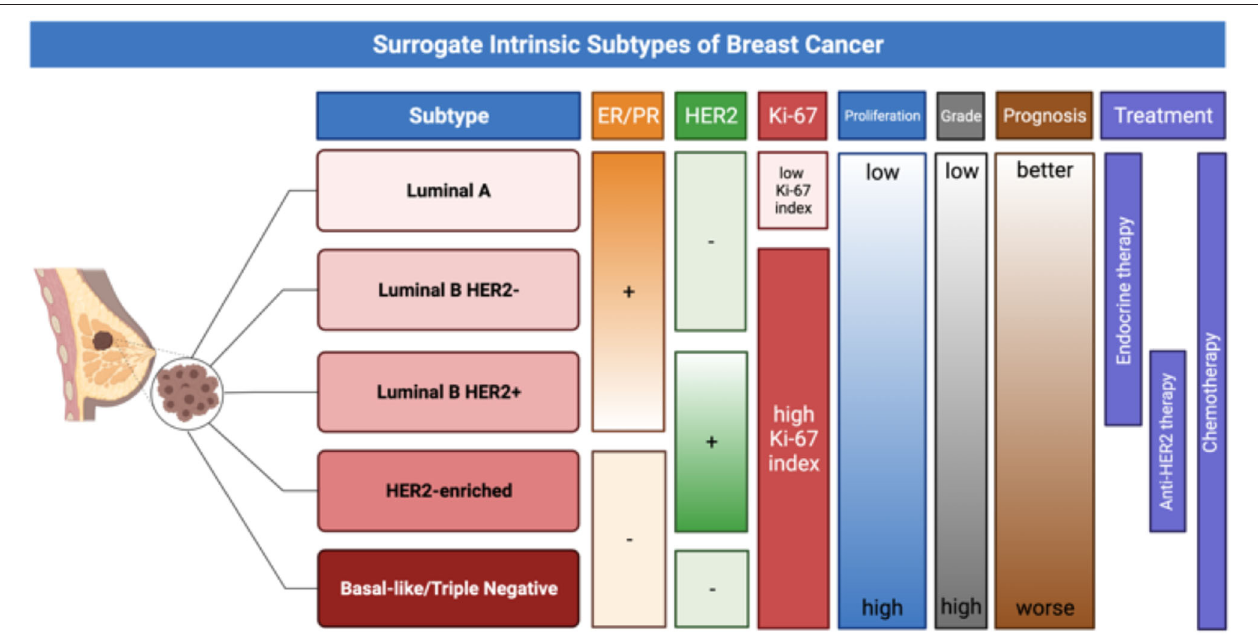
FIGURE 1 | The figure provides a schematic representation of surrogate intrinsic BC subtypes (14), based on histologic and molecular features, which have significant implication for prognosis and treatment choice.